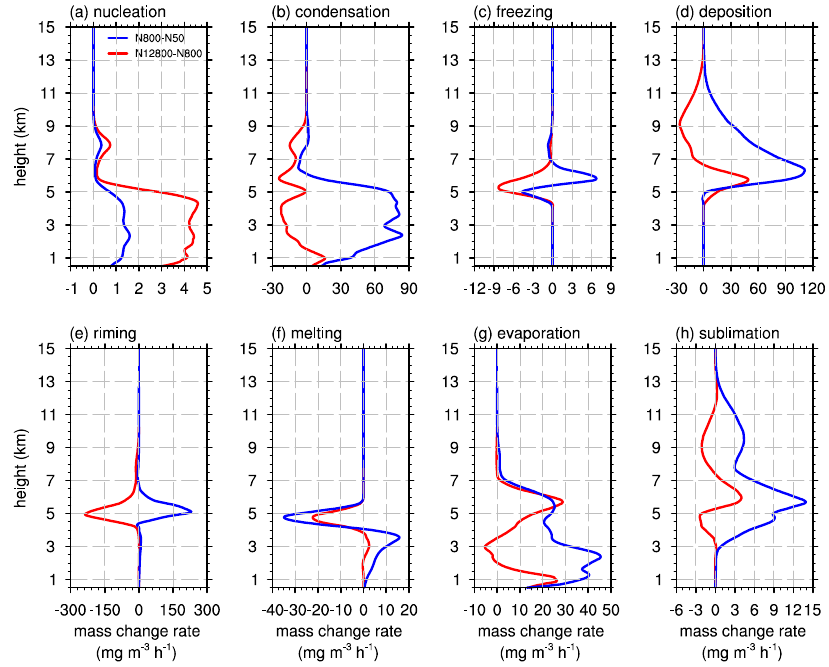
Figure 11. Vertical profiles of differences in the mass change rates attributable to ( a ) nucleation, ( b ) condensation, ( c ) freezing, ( d ) deposition, ( e ) riming, ( f ) melting, ( g ) evaporation, and ( h ) sublimation processes (blue) between N 0 = 800 cm − 3 and N 0 = 50 cm − 3 cases and (red) between N 0 = 12,800 cm − 3 and N 0 = 800 cm − 3 . Note that each panel uses its own scale.